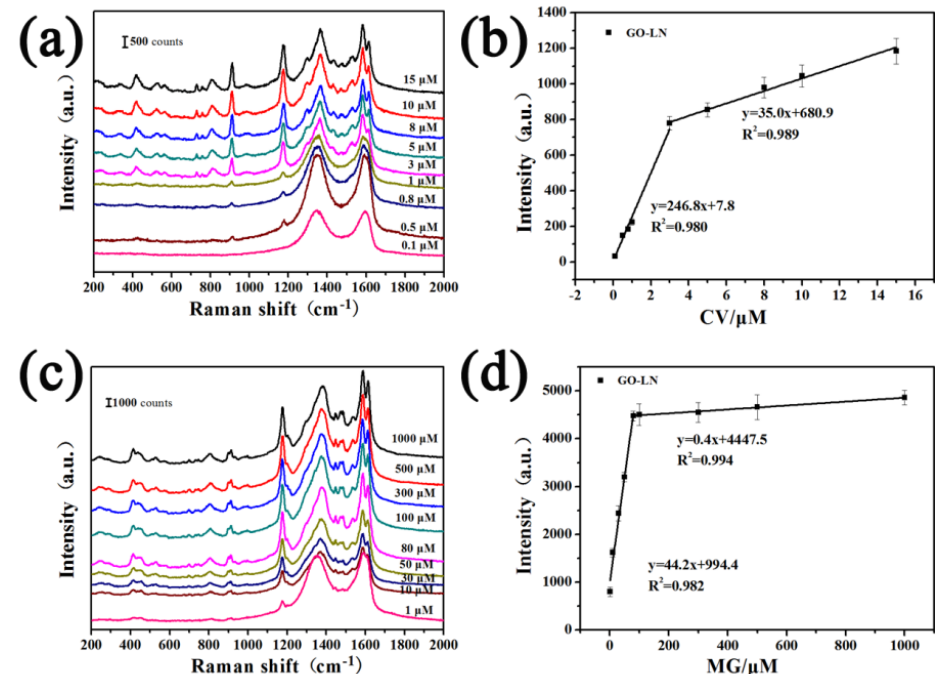
Figure 7. Raman spectra of ( a ) CV and ( c ) MG molecules deposited on GO-LN films by immersing in the solution with different concentrations; ( b ) the corresponding plots of Raman intensity of ~914 cm −1 peak of CV deposited on GO-LN vs. concentration; ( d ) the corresponding plots of Raman intensity of ~1178 cm −1 peak of MG deposited on GO-LN vs. concentration.